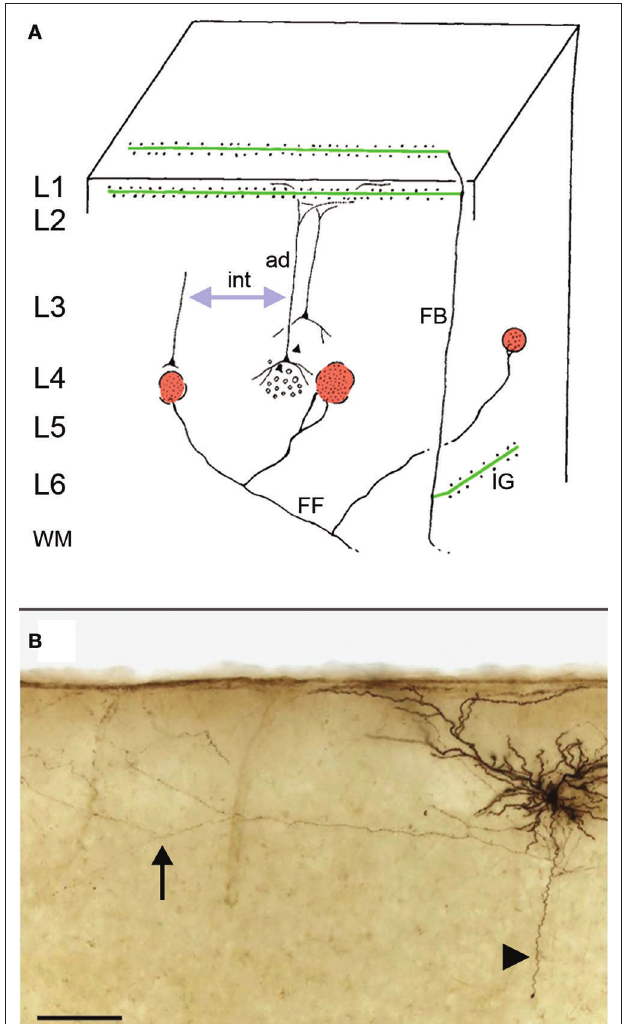
Figure 1 | Connectional building blocks: feedforward (FF), feedback (FB), and intrinsic (int) connections. (A) Feedforward (red) and intrinsic (blue arrow) connections are both modular (“columnar”). Pyramidal neurons postsynaptic to feedforward connections presumably are themselves interconnected, but how these extrinsic and intrinsic connections interact is poorly understood. Feedback connections (green) are typically divergent, presumably crossing over a territory corresponding to multiple columns. Modified from Rockland and Drash (1996). Ad=apical dendrite; ig=infragranular. (B) Pyramidal neuron in layer 2 of rat visual cortex (intracellularly filled with biocytin in vitro ). Arrowhead indicates descending axon (truncated in the slice preparation), and vertical arrow points to distal part of an intrinsic axon collateral in layer 2, 600 μm from the cell body (courtesy of Dr. Tohru Kurotani). Scale bar = 100